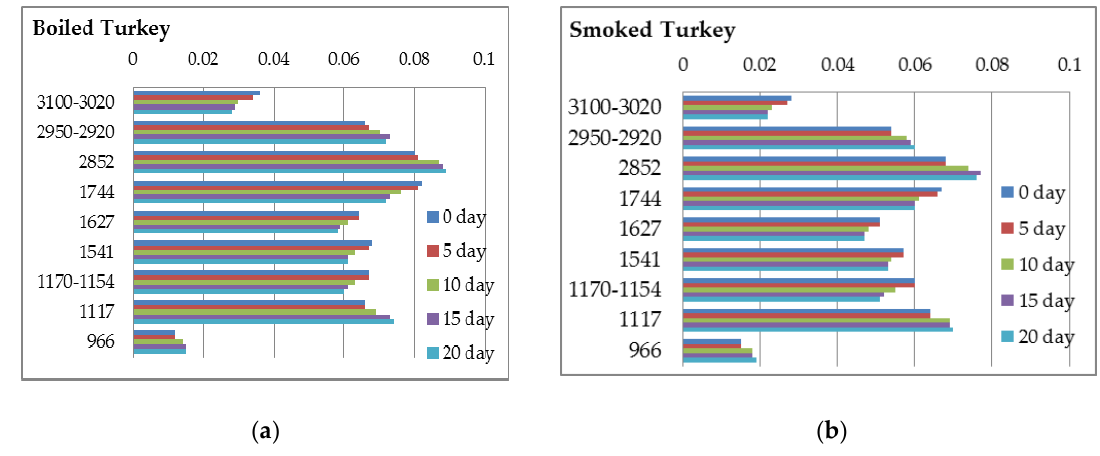
Figure 5. Spectral absorbance bands (intensities) (X-axis) at characteristic regions (cm − 1 ) (Y-axis) during storage in refrigeration for twenty days: ( a ) boiled-turkey hams; ( b ) smoked-turkey hams.